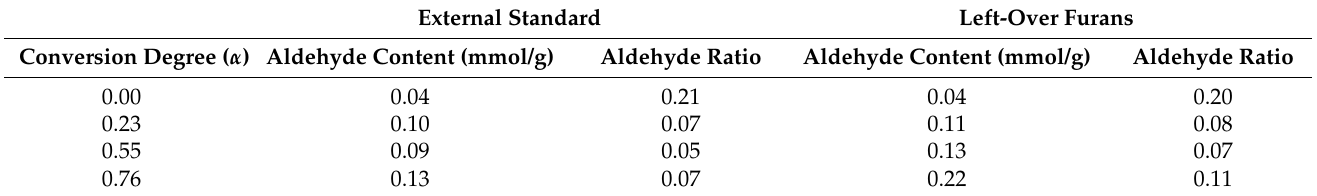
Figure 6. Quantitative 1 H NMR spectra of FA and PFA° resin focused on the aldehyde area. It was found that the concentration of aldehydes in PFA+ increase with the conver- sion degree, as well as the aldehyde ratio—over all the carbonyls [44]. Table 1 reports a similar behavior for PFA°. With the method using an external standard, the aldehyde con- centration increases very slightly over time with the course of polymerization. Nonethe- less, the aldehyde ratio remains steady during the whole polymerization of FA in the neat system. A similar trend is observed with the left-over furan method. Overall, PFA° com- prised up to 0.13 mmol/g of aldehydes, i.e., about 7% of its carbonyls. In comparison, the PFA+ resins comprise about 0.50 mmol/g of aldehydes in resin with a conversion degree of 0.83 and about 0.20 mmol/g of aldehydes for a resin with a conversion degree of 0.47. Consequently, polymerizing FA in a 50% aqueous solution stimulates the production of aldehydes either from a water-based or an oxidative pathway.